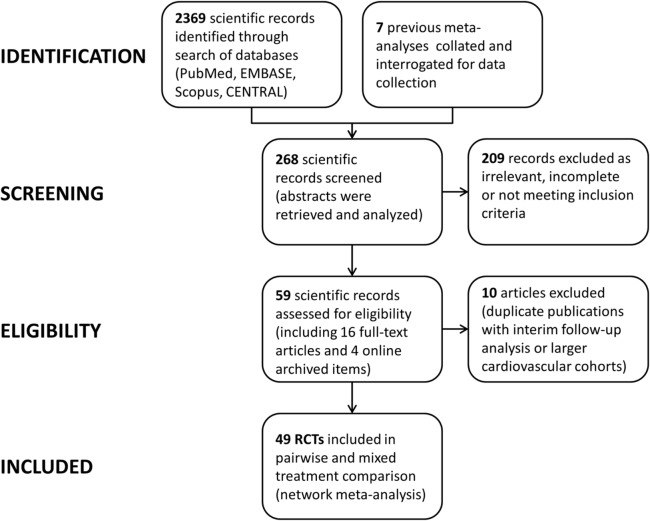
PRISMA flowchart.Trial selection process according to the PRISMA statement.